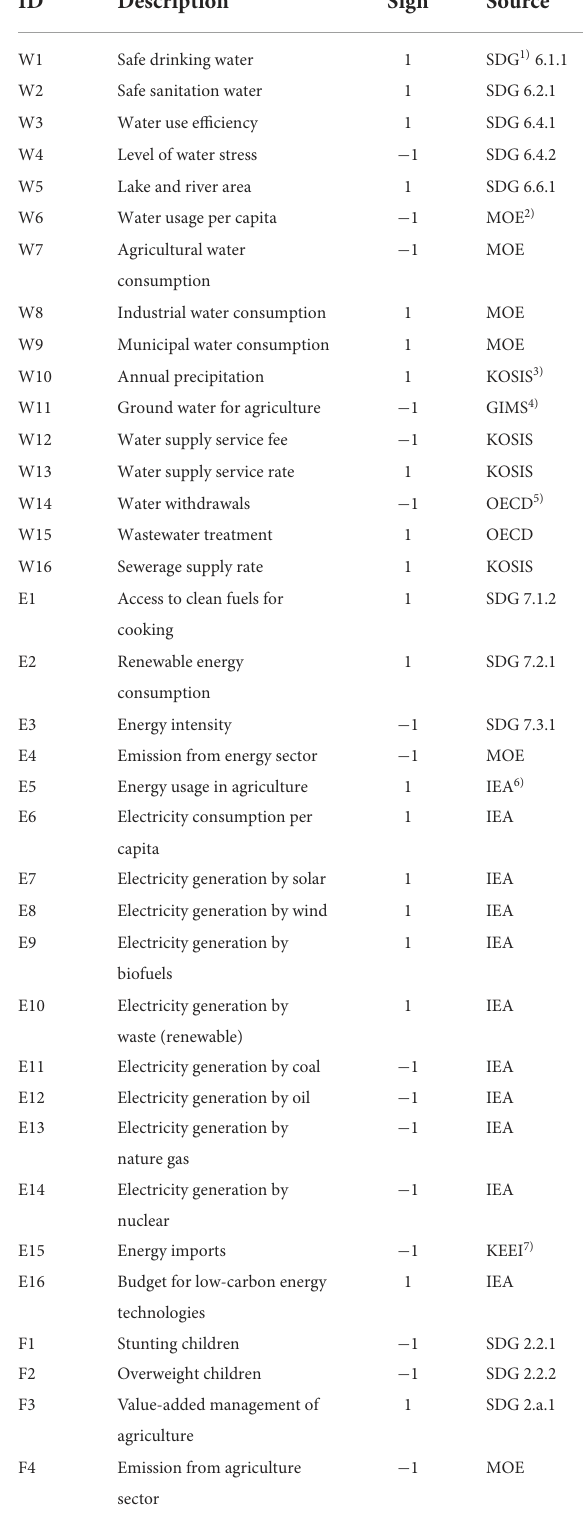
TABLE 1 Indicators selected to investigate the water, energy, and food (WEF) security nexus of South Korea.